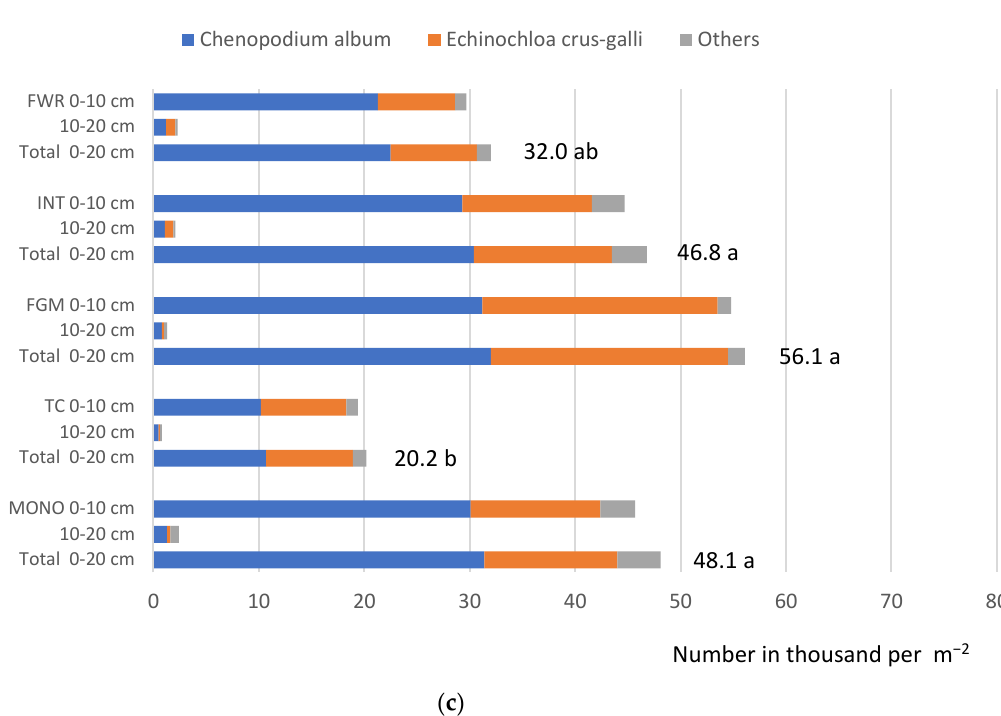
Figure 4. Weed seed bank dominant species of weed seeds after winter rye harvest in 0–10 and 10–20 cm soil layers in ( a ) 2012; ( b ) 2014; ( c ) 2016. Note: different letters indicate significant differences between the treatments ( p ≤ 0.05); FWR— field rotation with row crops; INT—intensive rotation; FGM—rotation for green manure; TC—three-course rotation; MONO—rye monoculture.